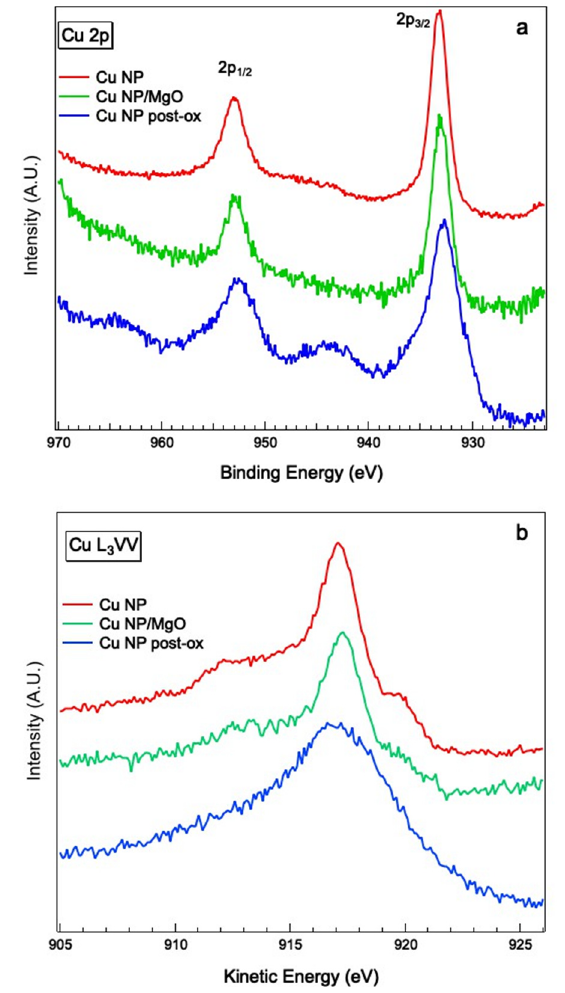
Figure 7. ( a ) Cu 2p XPS spectra obtained from Cu NPs (red line), Cu/MgO NPs (green line), and